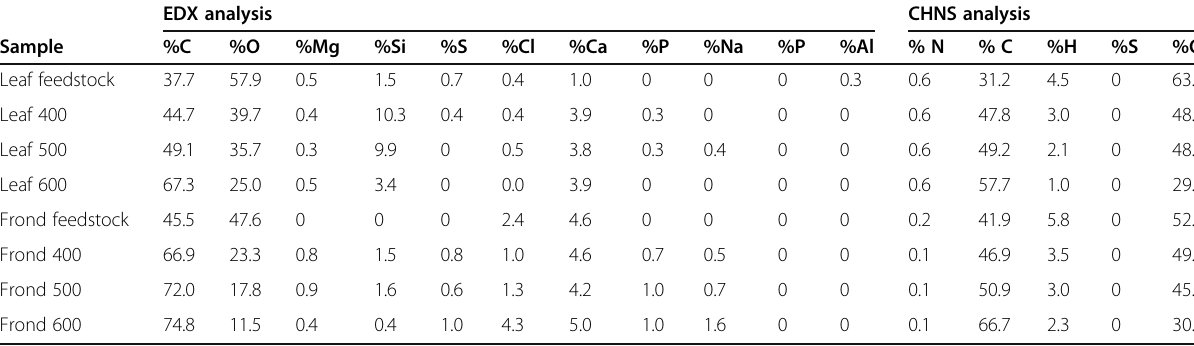
Table 2 Elemental analysis for leaf and frond feedstock and biochar samples EDX